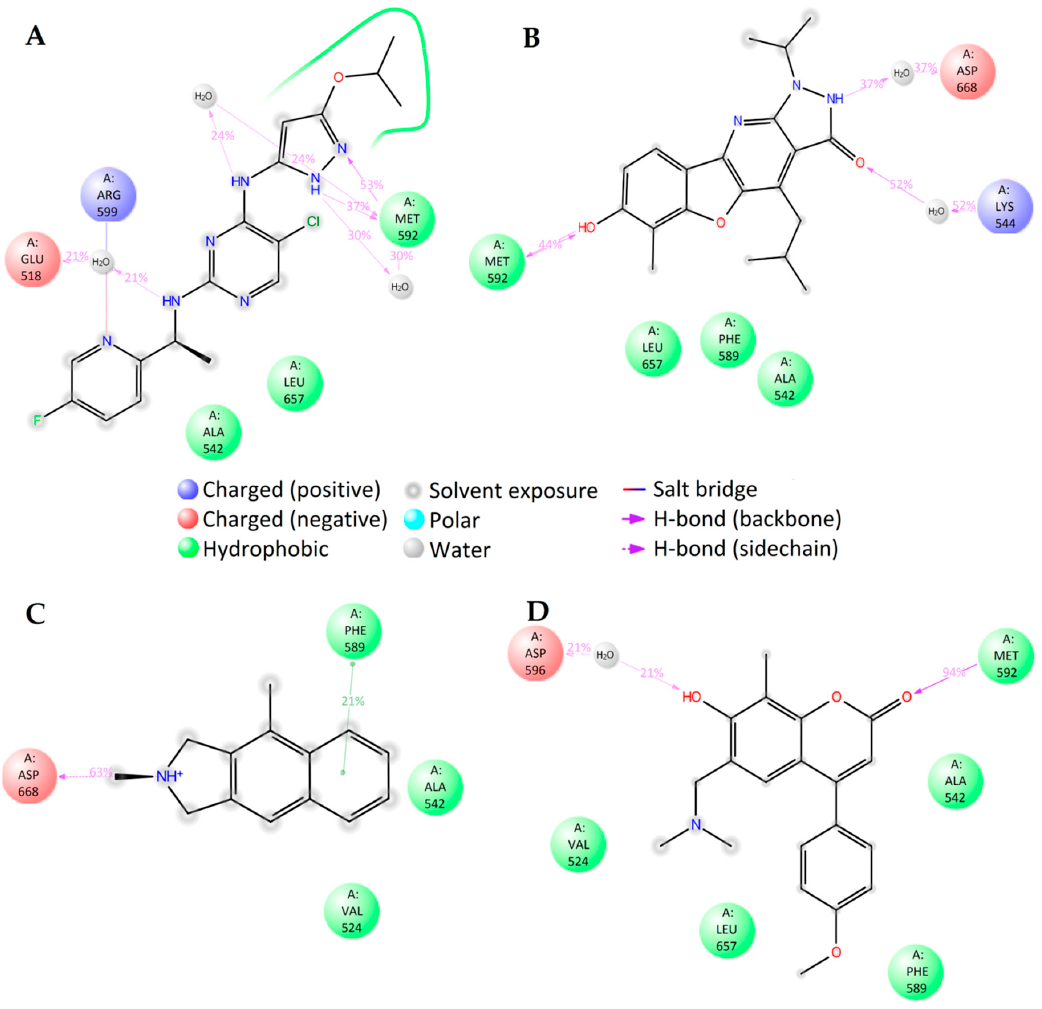
Figure 8. 2D summary of molecular dynamics calculated contacts between compounds ( A ) AZ-23, ( B ) 1T , ( C ) 2T , and ( D ) 3T and TrkA.